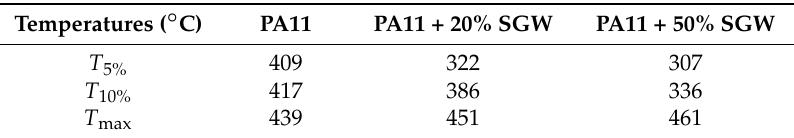
Table 1. Onset temperatures for the 5% and 10% of weight loss and temperature in the maximum decomposition rate.